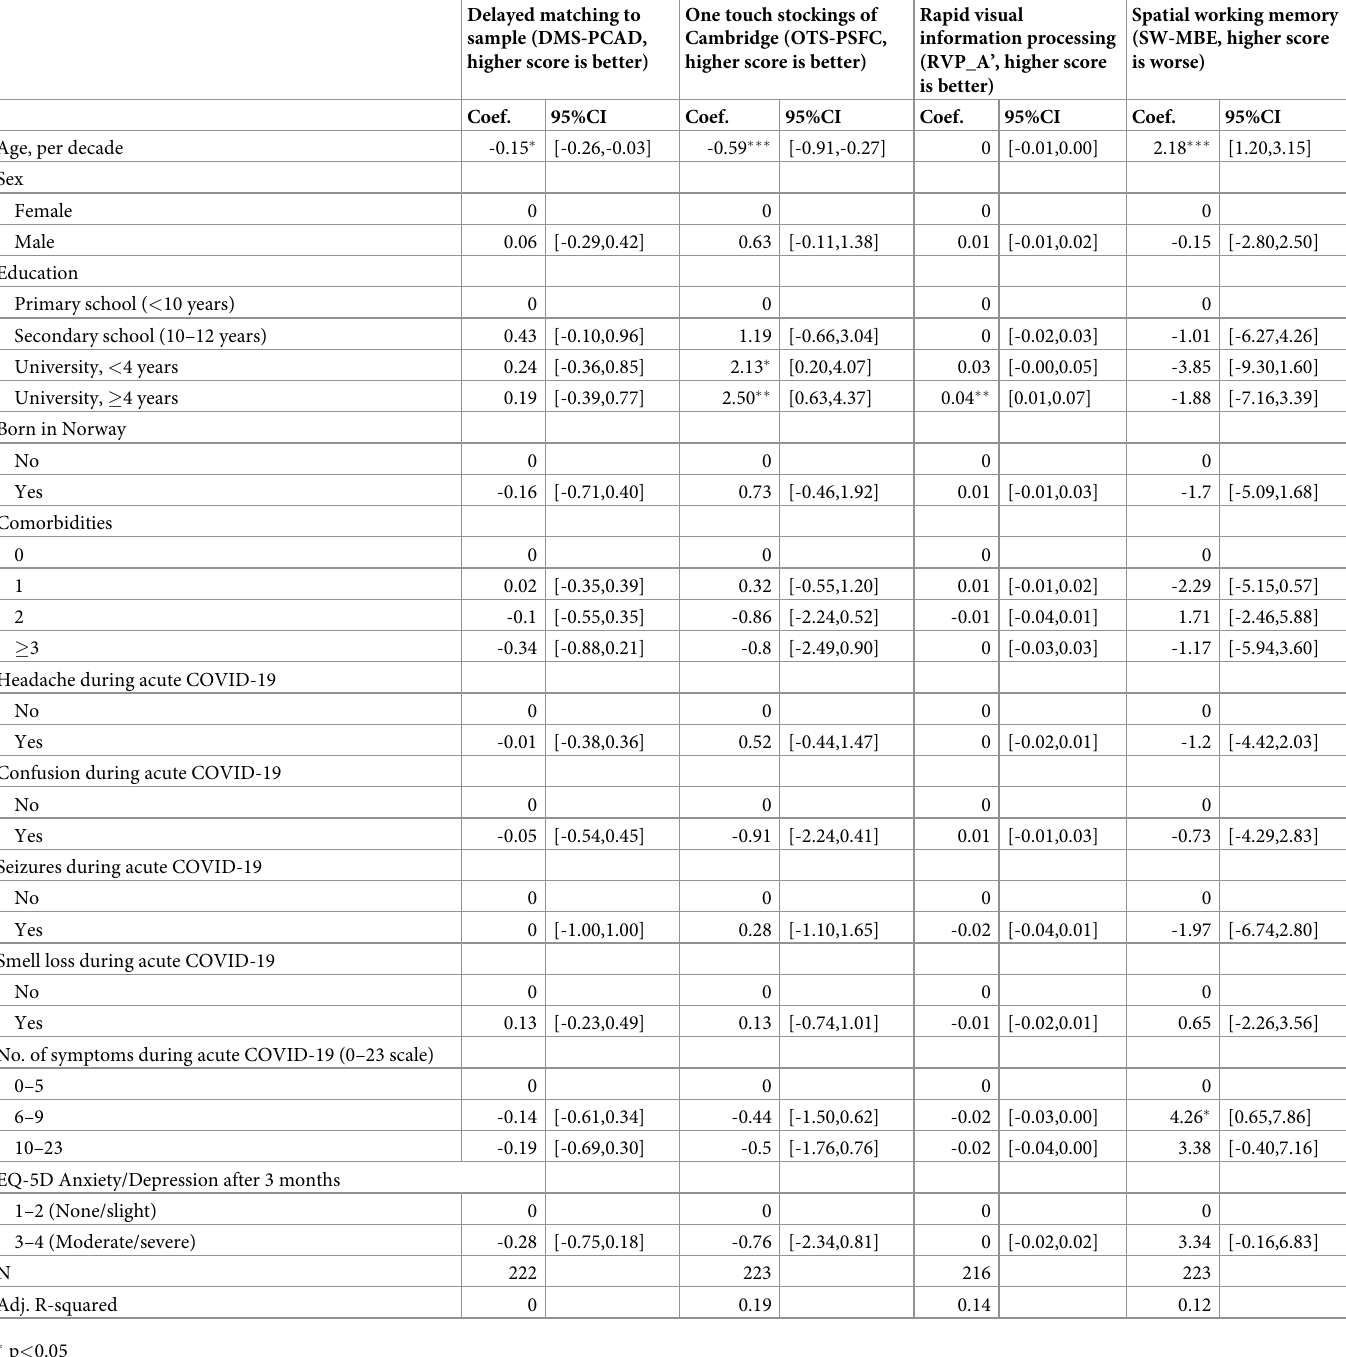
Table 5. Determinants of cognitive test scores. Unstandardized beta coefficients with 95% confidence intervals and p-values, multiple linear regression analysis with